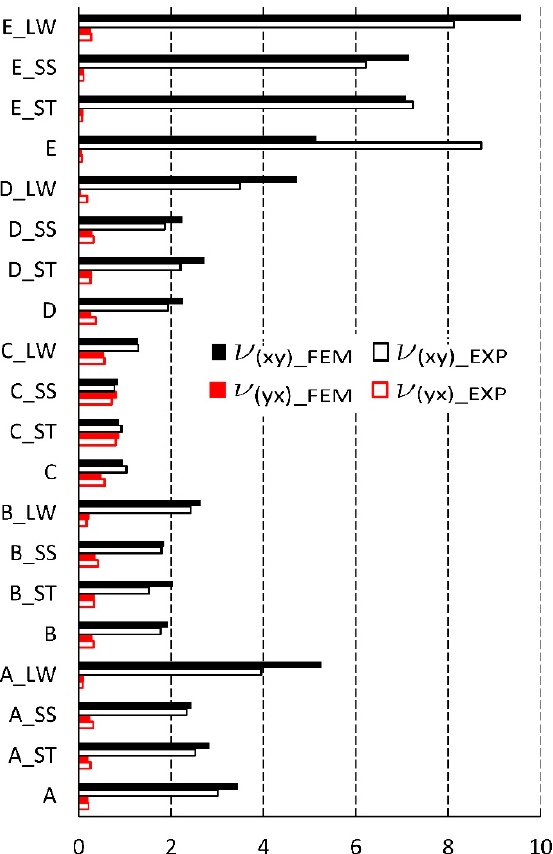
Figure 12. Poisson’s ratio for cell types: A, B, C, D, E (EXP-experimental research, FEM-numerical calculations).